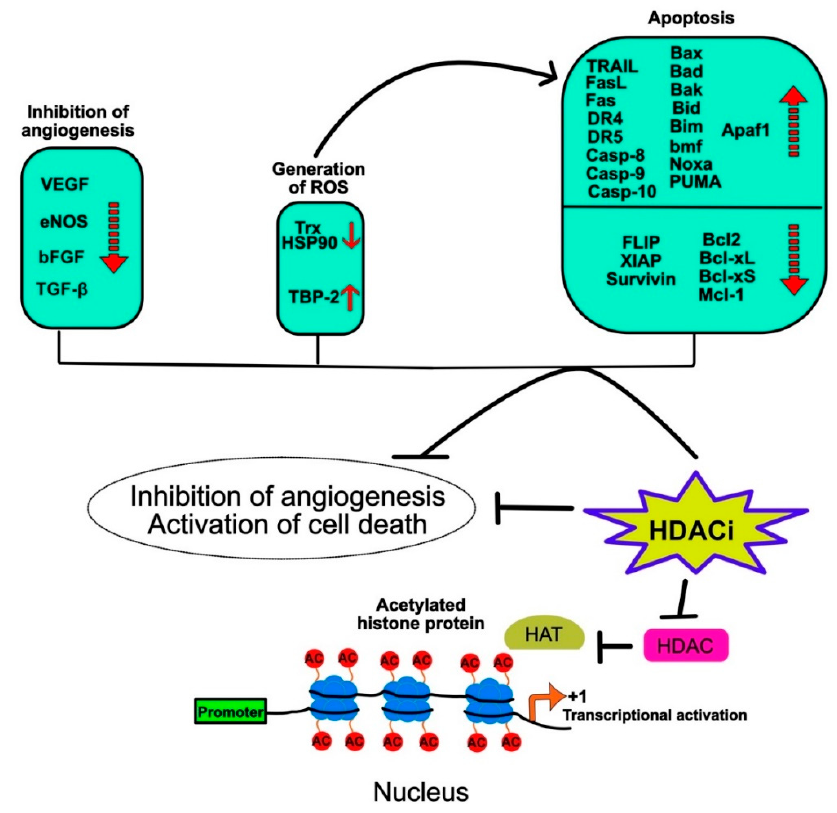
Figure 8. Schematic representation of the main molecular events-induced by HDAC inhibitors preventing tumor metastasis and inducing tumor cell death.